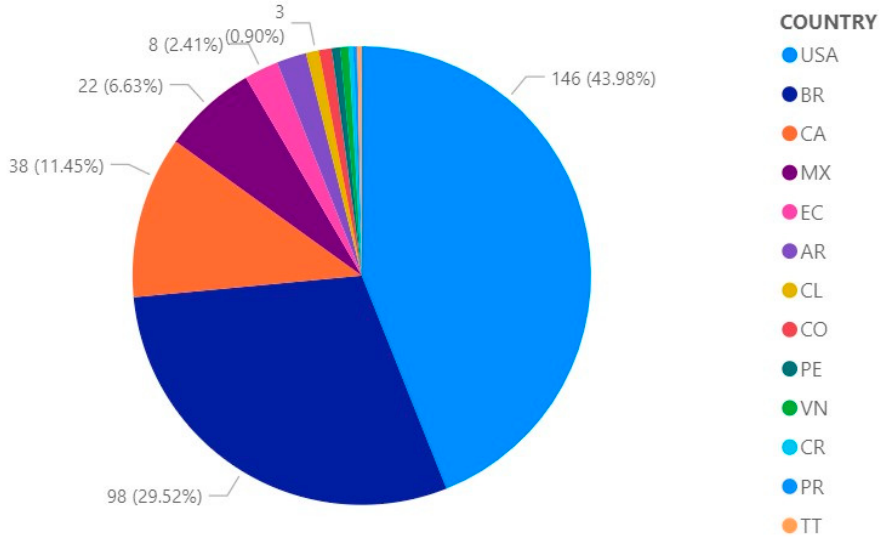
Figure 4. Contribution of scientific publications by country in Scopus.